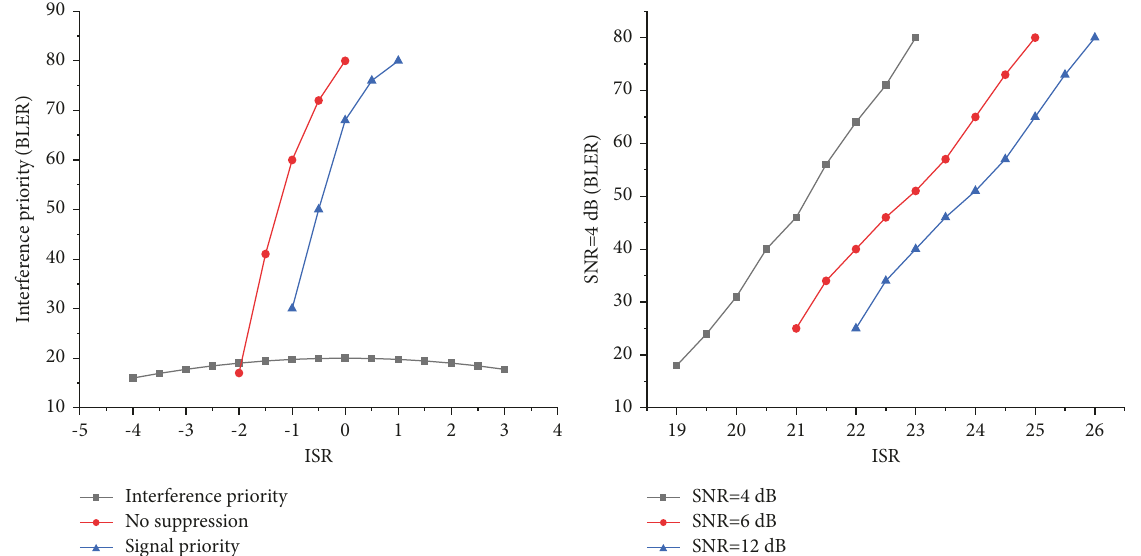
Figure 10: Performance comparison of block error rate under different iteration sequences under wideband